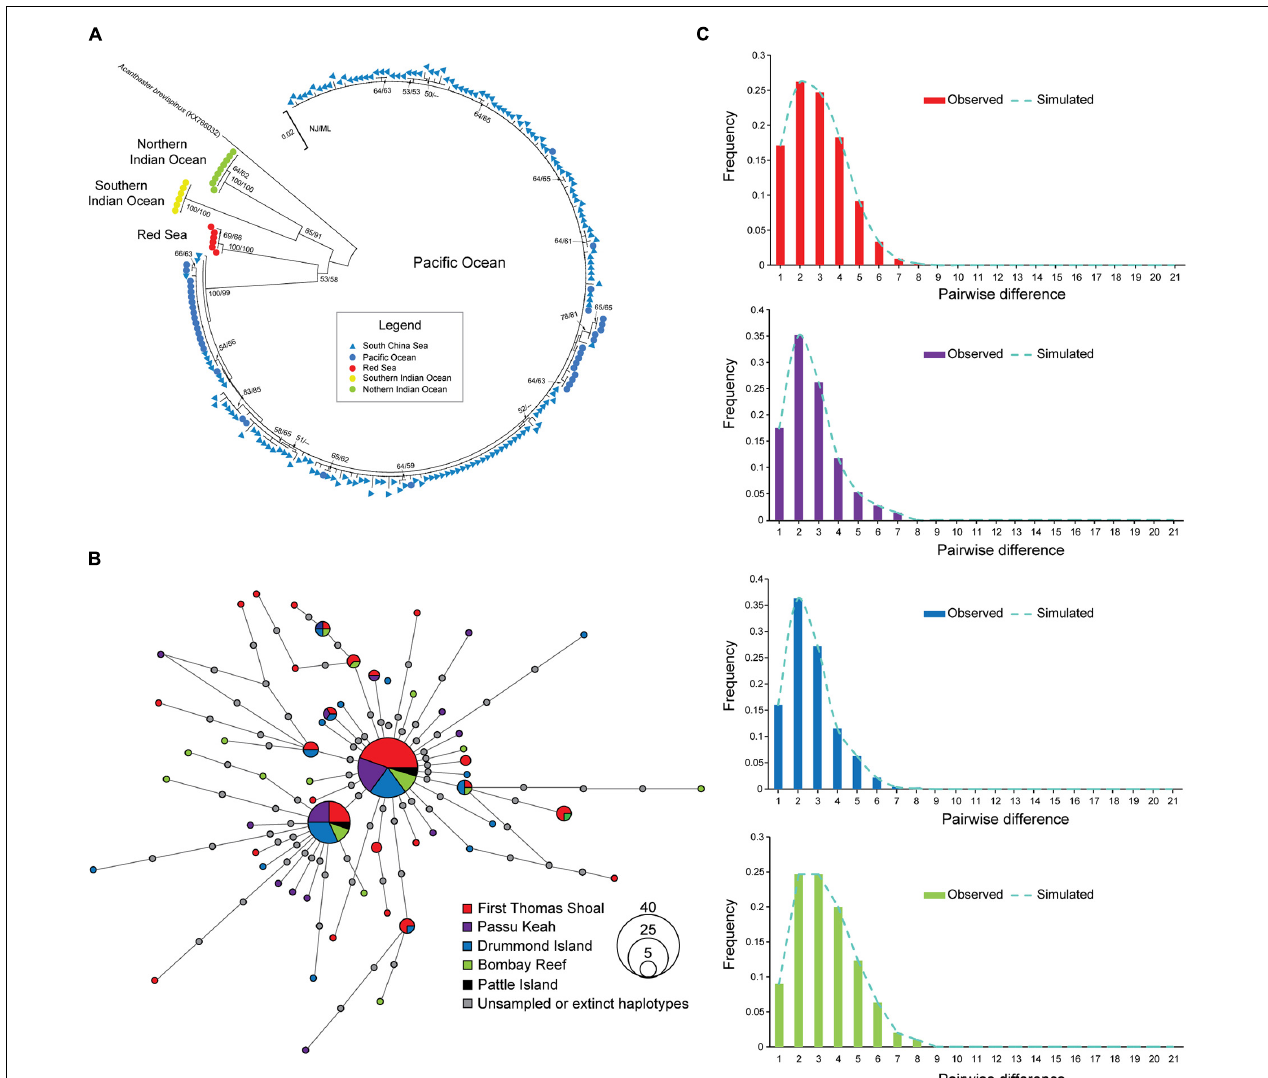
FIGURE 2 | Phylogenetic relationship, haplotype network and historical demography of crown-of-thorns starfish (COTS) in the South China Sea (SCS). (A) Neighbor joining (NJ) tree of mitochondrial cytochrome oxidase subunit I gene (COI) of COTS was presented. (B) COI sequence based on median-joining algorithm. Colors represent geographic COTS populations including First Thomas Shoal (FTS), Passu Keah (PK), Drummond Island (DI), and Bombay Reef (BR) in the SCS, and gray circles represent extinct or unsampled haplotypes. Circle size is proportional to the haplotype frequency. (C) Pairwise mismatch distribution for COTS populations in FTS, PK, DI, and BR in the